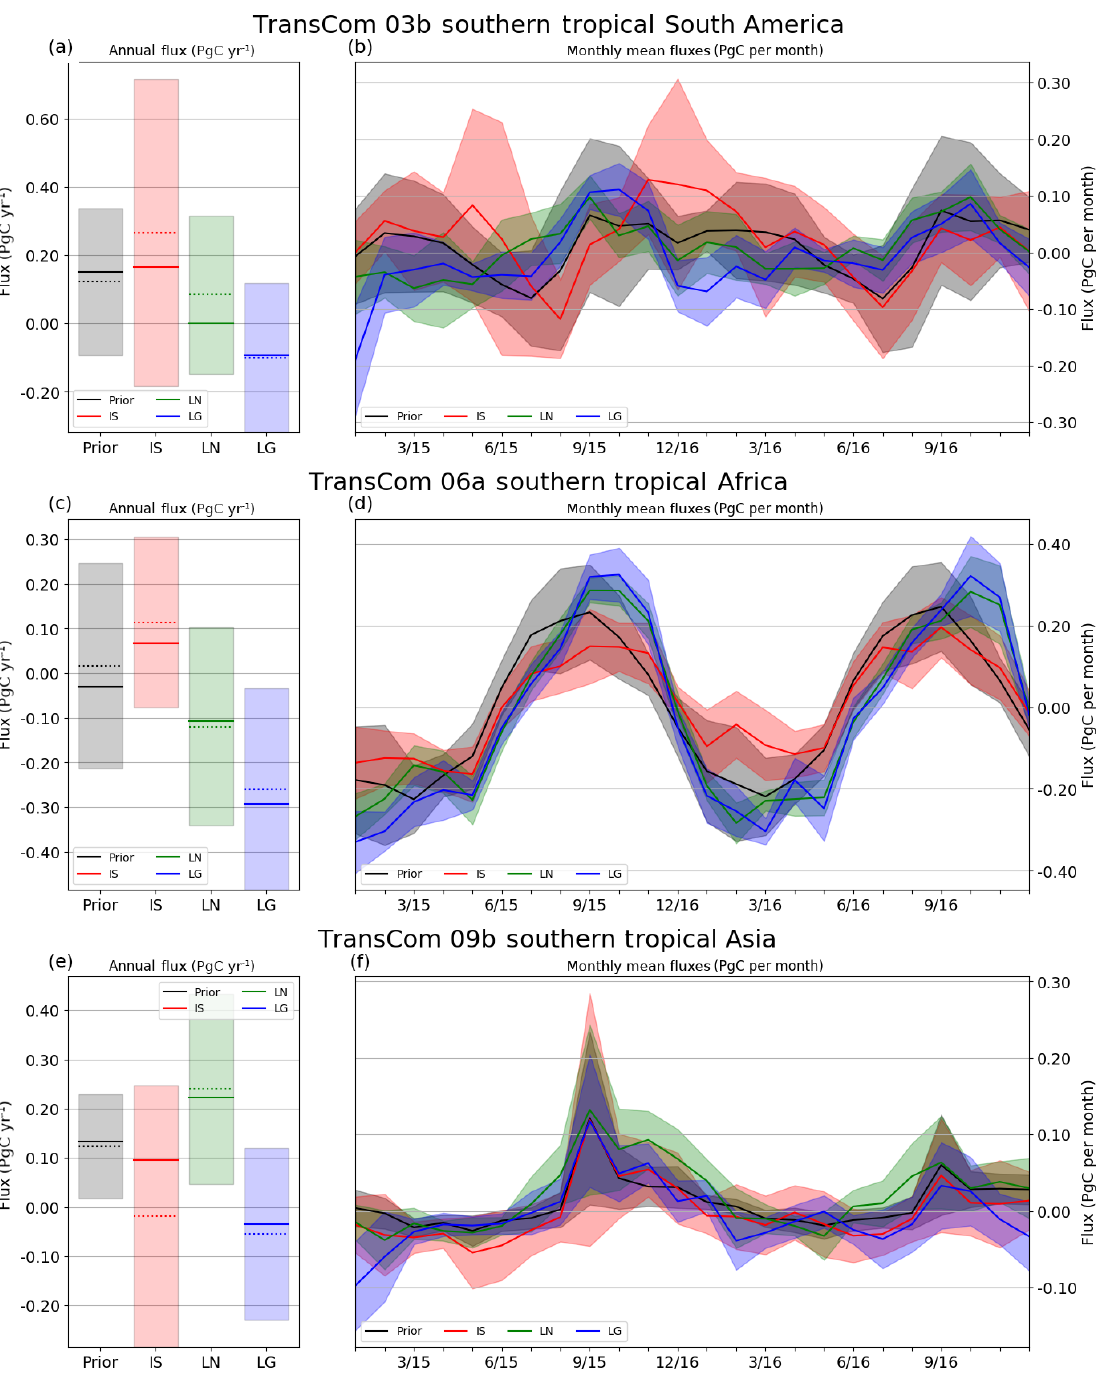
Figure 7. As in Fig. 3, but for selected terrestrial regions in the southern tropics on different continents. Among the three continents, satellite- derived posterior fluxes differ substantially from the prior and in situ constrained fluxes only in tropical Africa, where the peak outgassing is shifted later in the year by a few